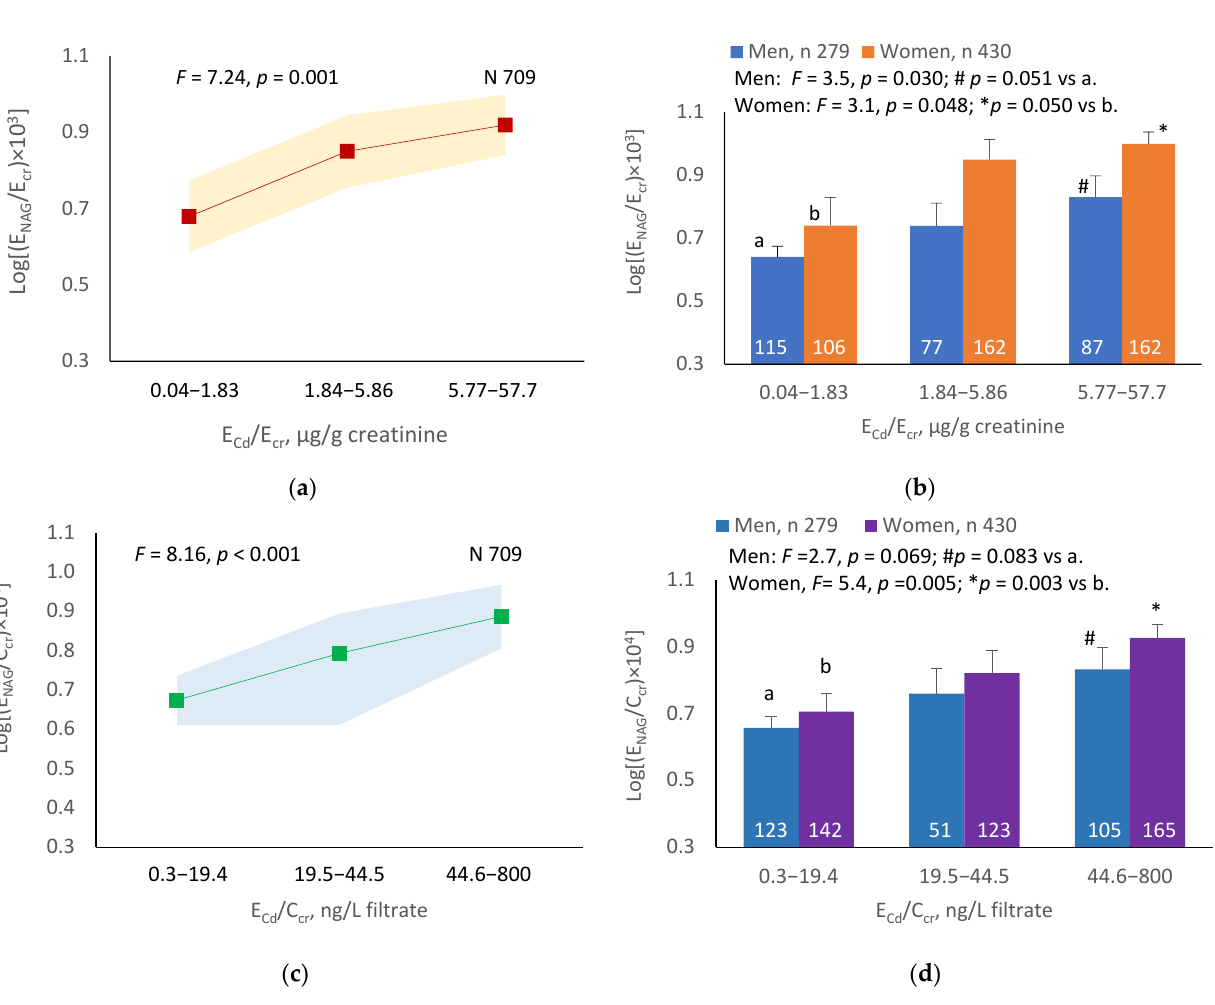
The mean NAG excretion was highest at E Cd /E cr Level 1, intermediate at Level 2 and lowest at Level 3 ( p = 0.001) (Figure 2a). In men and women, the mean E β2M /E cr was higher in those with E Cd /E cr Level 3, compared with E Cd /E cr Level 1 (Figure 2b). Similarly, the mean E NAG /E cr was lowest at E Cd /C cr Level 1, intermediate at Level 2 and highest at Level 3 ( p < 0.001) (Figure 2c), and the mean E NAG /E cr was higher in men and women who had